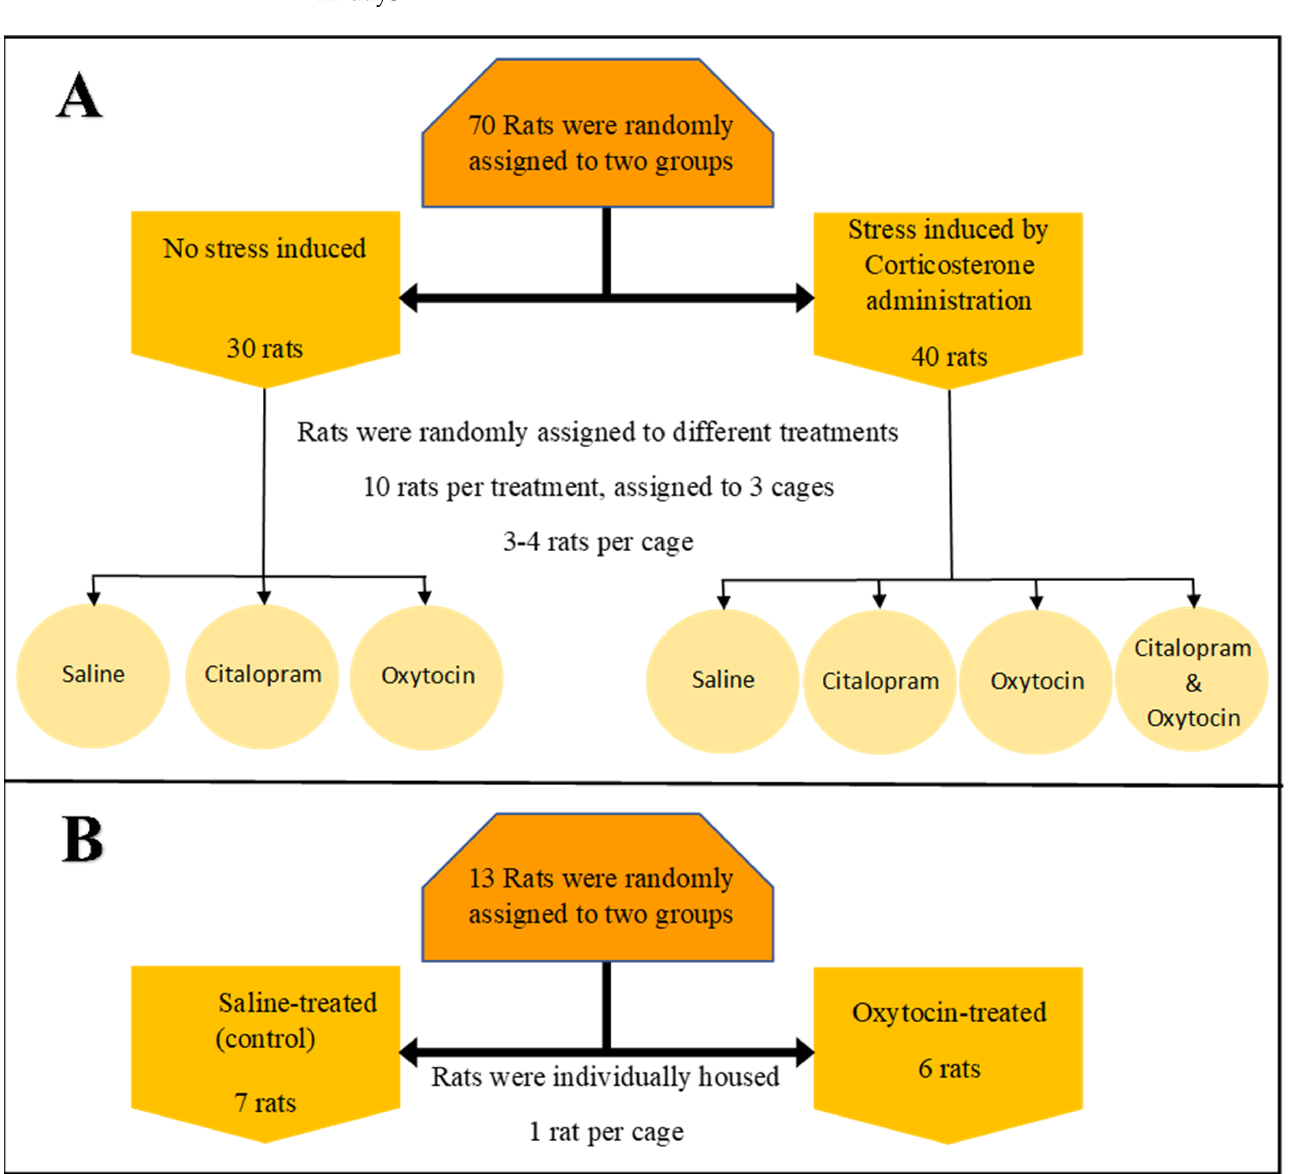
Figure 1. Experimental setup. All rats were 8-week-old male Wistar rats weighing 250–300 g. After a 4-day adaptation period, the rats were randomly divided into experimental groups. Fecal samples were collected randomly from each cage on day 1 and day 20 of the experiment. Saline citalopram or oxytocin was given from day 7 to day 21 by subcutaneous administration and was injected at the same time every day (9:00–10:00 a.m.): ( A ) First experiment, multidrug environment. Stress was induced by non-invasive drinking water-mediated corticosterone administration for 21 days. ( B ) Second experiment, single drug environment.